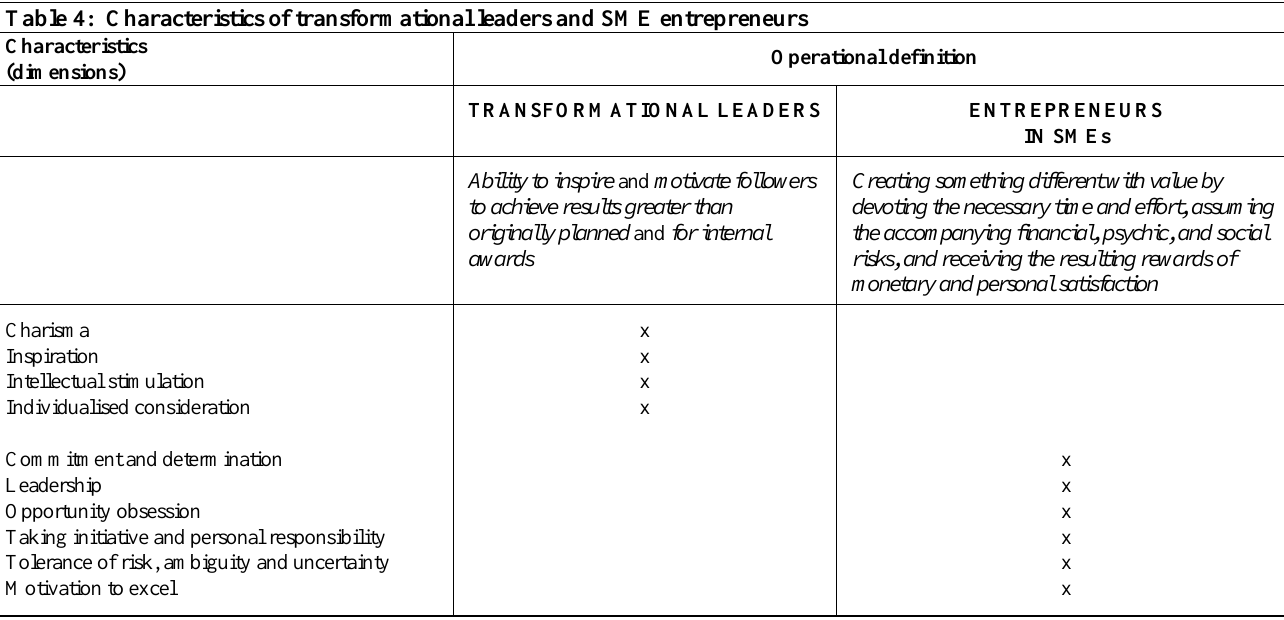
Table 4: Characteristics of transformational leaders and SME entrepreneurs